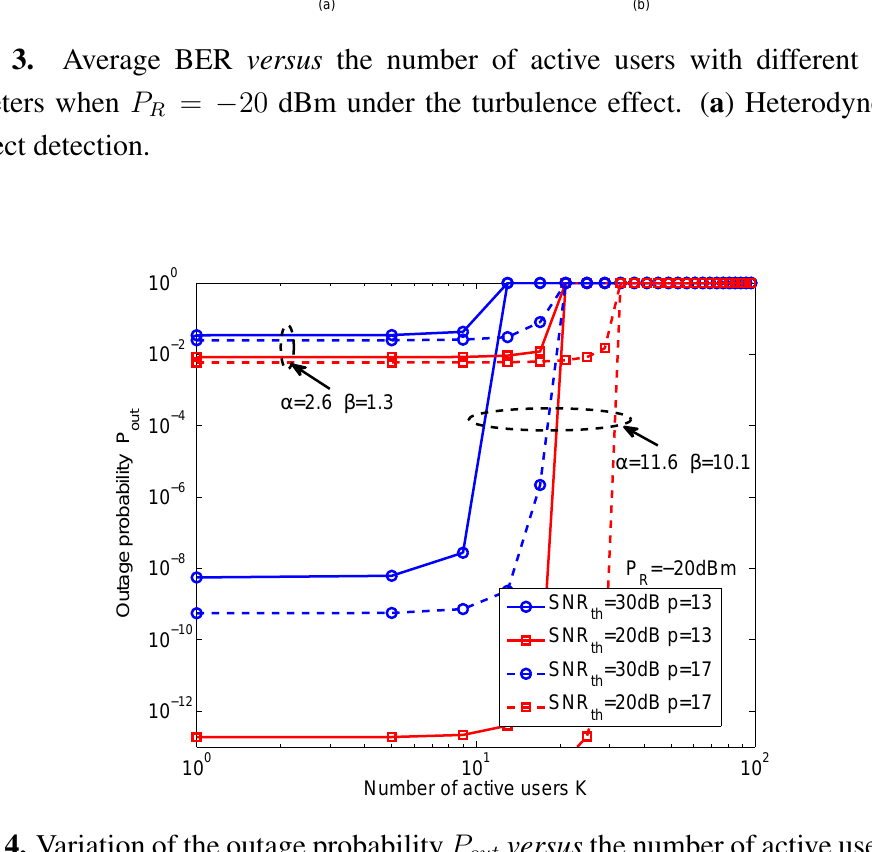
Figure 4. Variation of the outage probability P P = − 20 dBm under a range of turbulence R